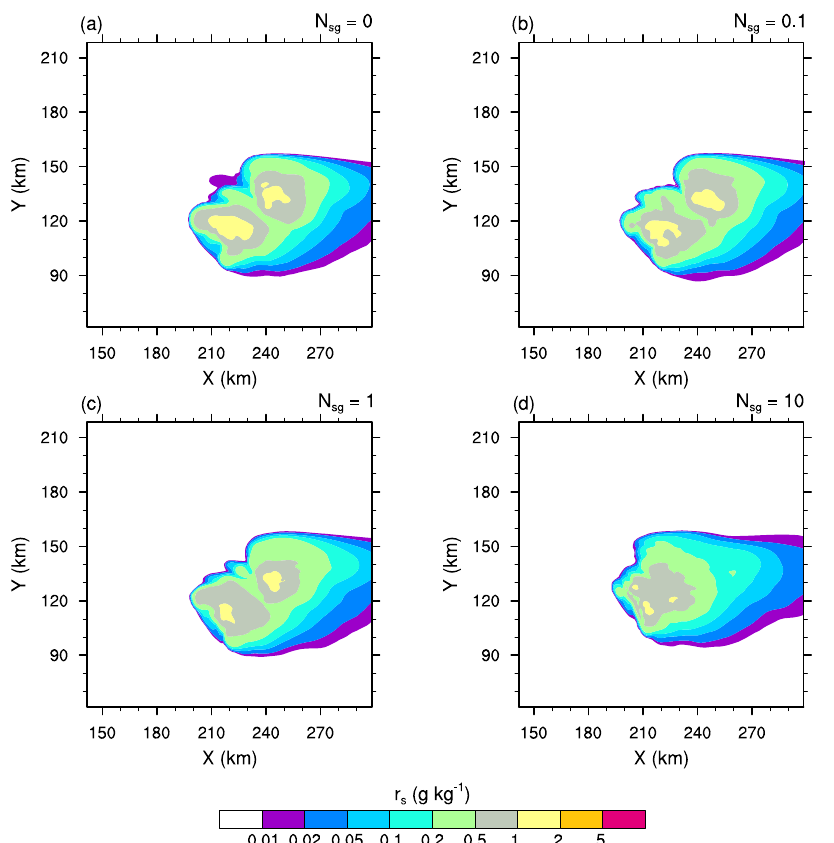
Figure 4. As in Fig. 3 but for the mixing ratios of snow aggregates ( r s